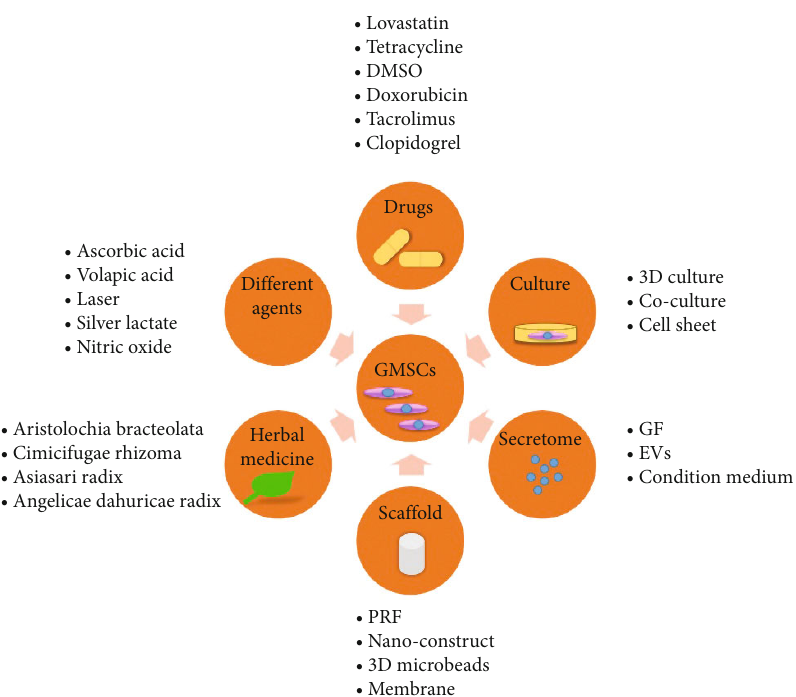
Figure 5: Di ff erent factors in fl uence the osteogenic potential of